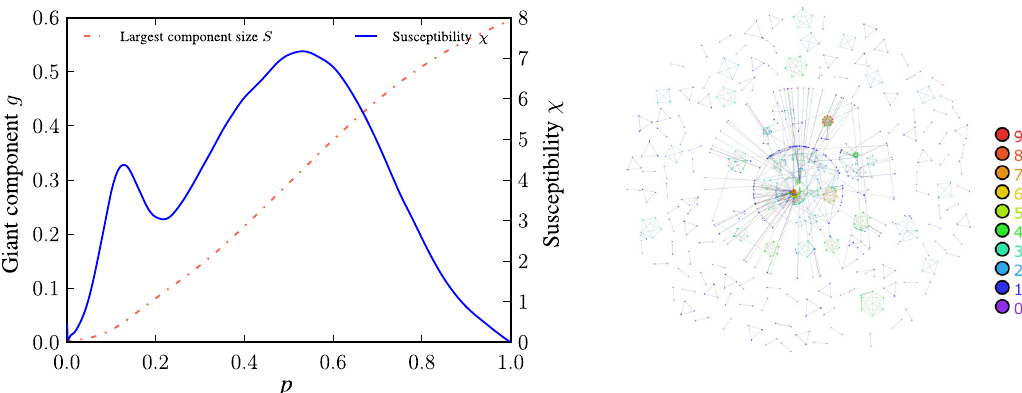
FIG. 12. Left panel: Bond percolation simulations for the human disease network. The relative size of the largest connected component g and its susceptibility χ as a function of the bond occupation probability p . Right panel: m -core decomposition.